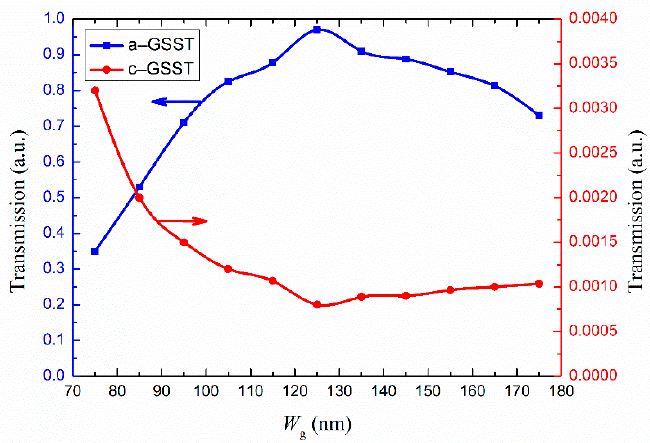
Figure 7. Normalized transmission in the racetrack MRR as a function of DC coupler gap W g , when GSST is in amorphous and crystalline states, respectively.